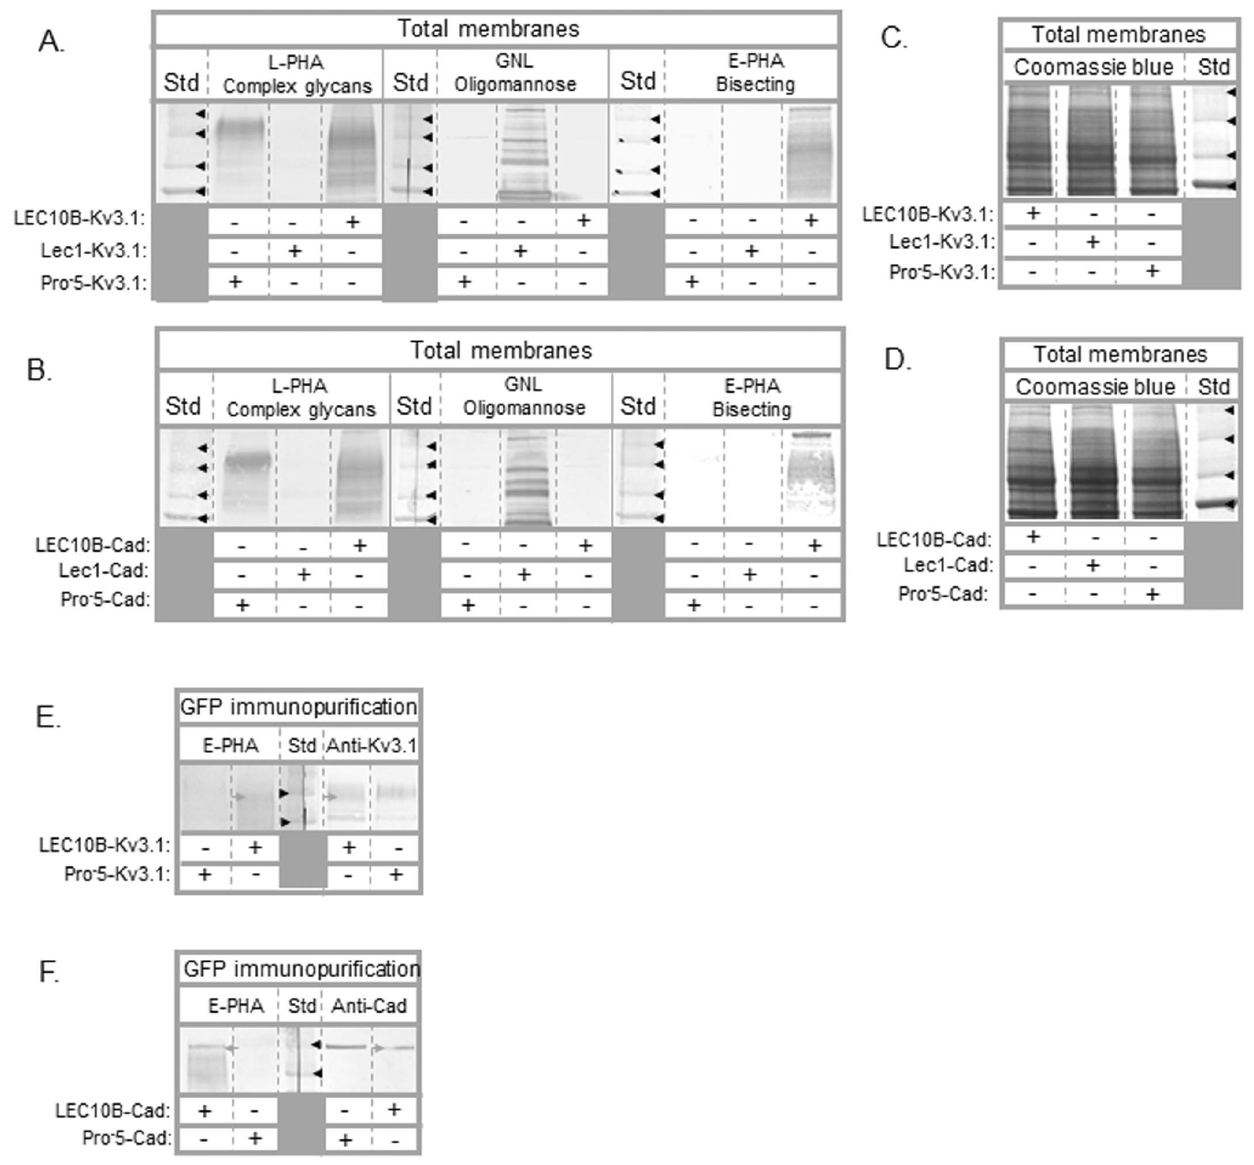
Figure 2. Lectin blots of total membranes and immunopurified Kv3.1 and E-cadherin proteins from transfected CHO cell lines. Total membranes ( , 25 m g) from Pro - 5, Lec1, and LEC10B cells transfected with wild type Kv3.1 (A) and E-cadherin (B) were probed with L-PHA ( , 5 m g/mL), E-PHA (5–10 m g/mL), and GNL ( , 10 m g/mL). Similar amounts of electrophoresed proteins from total membranes were also stained with Coomassie blue (C,D). Black arrowheads denote the 75, 100, 150 and 250 kDa markers. Lectin blots of immunopurified GFP tagged Kv3.1 and E-cadherin from transfected Pro - 5 and LEC10B cells (E,F). Glycoproteins were probed with E-PHA (5–20 m g/mL). Western blots were run in parallel to denote position and relative amount of GFP-Kv3.1 and E-cadherin protein. Grey arrowheads point to GFP tagged Kv3.1 (E) and E-cadherin (F) proteins expressed in LEC10B cells while black arrowheads represent the 100 and 150 kDa markers. doi:10.1371/journal.pone.0075013.g002 expressed in LEC10B cells (Figure 2E, lane 4), and that the top total membrane proteins loaded were similar, as shown by lectin stained band was at a similar position as the E-cadherin coomassie blue staining of PVDF membranes (Figure 2C and 2D). immunoband from E-cadherin transfected LEC10B cells Lectin blots of immunopurified GFP tagged Kv3.1 (Figure 2E, (Figure 2F, lane 5). Lectin blots, along with Western blots and lane 2) and E-cadherin (Figure 2F, lane 1) showed that E-PHA glycosidase digestion reactions, revealed that the major form of interacted with glycoproteins from Kv3.1 and E-cadherin trans- either of Kv3.1 or E-cadherin glycoproteins expressed in Pro - 5, fected LEC10B cells, respectively. Alternatively, E-PHA interac- Lec1 and LEC10B cell lines consist of complex, oligomannose and tions were unobserved from Kv3.1 (Figure 2E, lane 1) and E- bisecting type N -glycans, respectively. These results are in cadherin (Figure 2F, lane 2) transfected Pro - 5 cells. Adjacent agreement with previous studies of these CHO cell lines [13,14]. Western blots revealed that lectin staining was observed at a As such, we will refer to the predominant form of wild type Kv3.1 similar position as the immunoband of the Kv3.1 glycoprotein